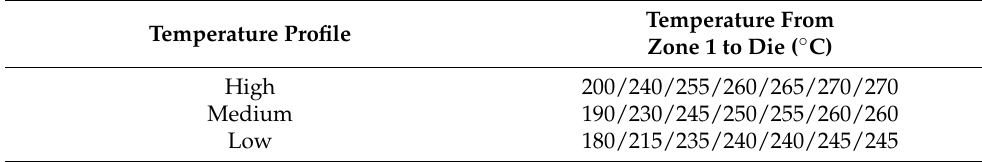
Table 1. Processing conditions considered in this study.